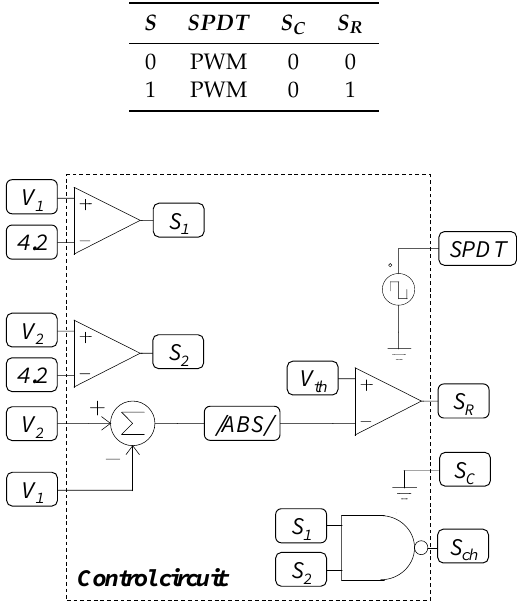
Table 2. Truth table of the switches in resistor-based mode of operation.